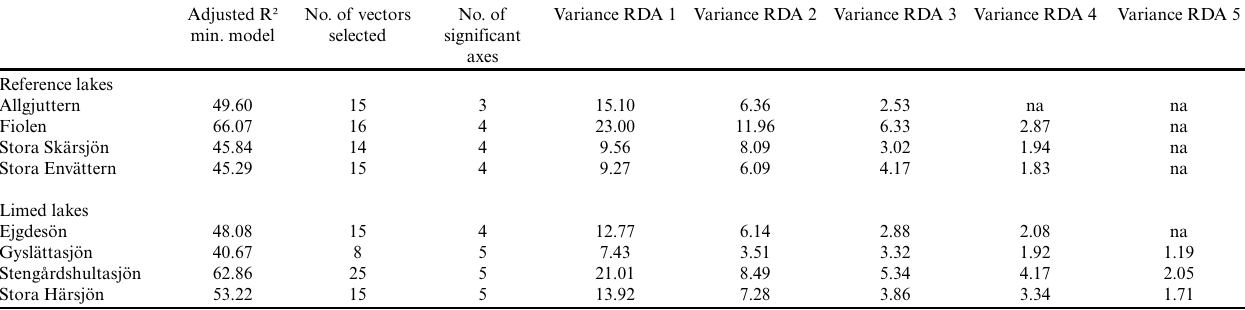
Fig. 2 . Temporal patterns of Ca:Mg ratios as a surrogate of management disturbance imposed by liming compared to patterns of reference lakes.